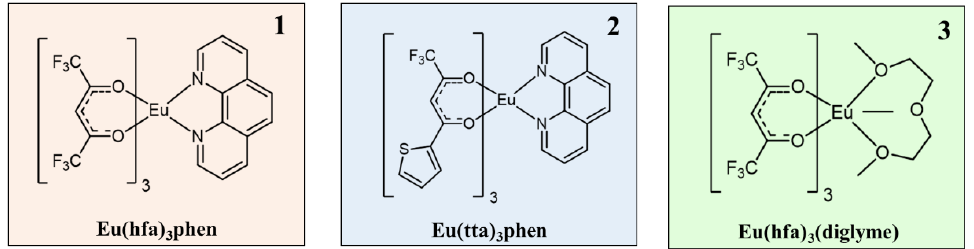
Figure 1. Molecular structures of ( 1 ) [Eu(hfa) 3 (phen)], ( 2 ) [Eu(tta) 3 (phen)] and ( 3 ) [Eu(hfa) 3 (diglyme)]